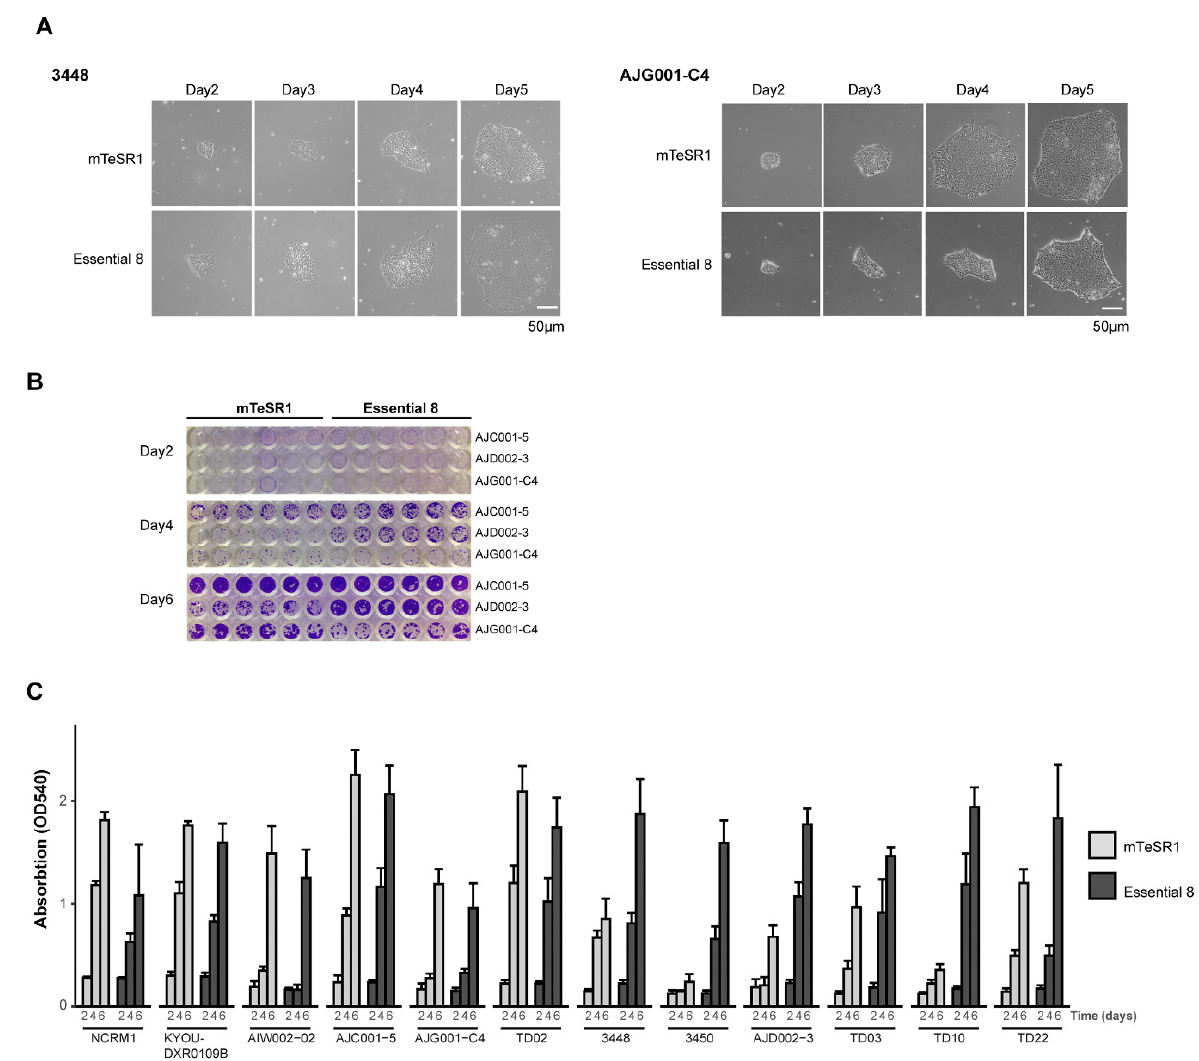
Figure 2. HiPSC growth and proliferation under different conditions. ( A ) Representative daily morphology of hiPSCs maintained in mTeSR1 or E8 media. Both cell lines show smooth-edged, tightly packed cells with a large nucleus-to-cytoplasm ratio. AJG001-C4 cells grow slightly better in mTeSR1 media, while 3448 proliferate better in E8. ( B ) CV assay of representative cell lines grown in mTeSR1 and E8. AJC001-5 grows well in both media. AJG001-C4 grows better in mTeSR1 media, while AJD002-3 cells proliferate best in E8. ( C ) Quantification of the hiPSCs’ survival and growth in different media. The CV stain was dissolved in methanol and optical density was measured at 540 nm (OD540). The mean and the standard deviation are from six replicates from two independent experiments.